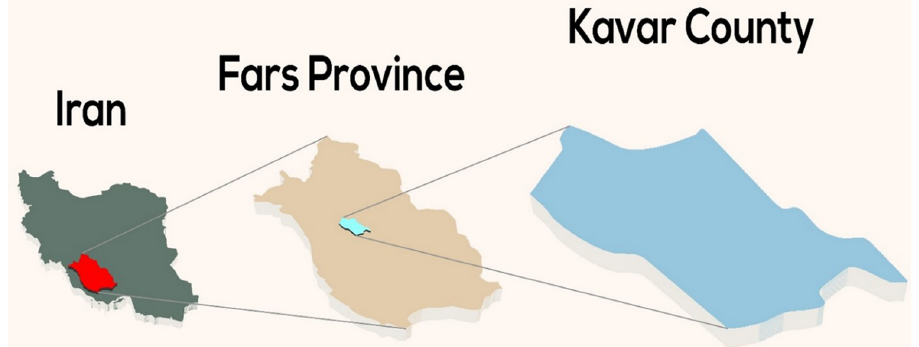
Fig 1. Location of Kavar County in